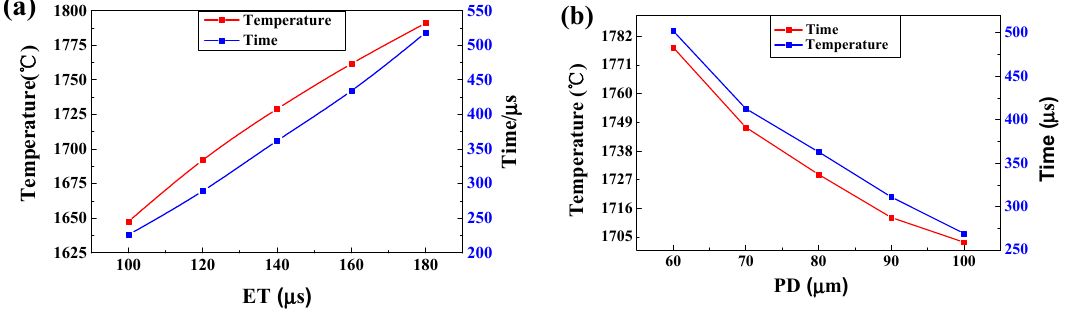
Figure 7. The maximum temperature and the liquid lifetime of the melt pool at point 2. Using different ET (PD = 80 μ m) ( a ) and different PD (ET = 140 μ s) ( b ).